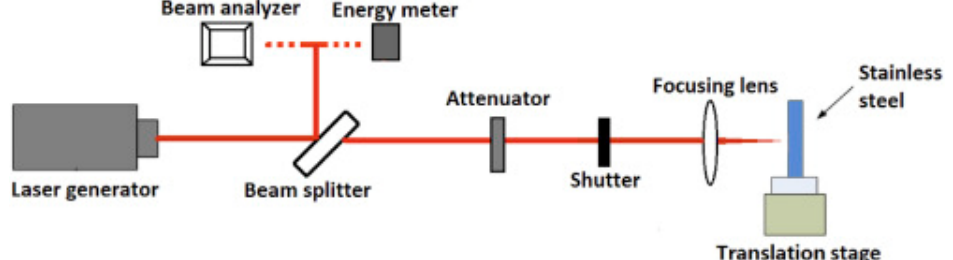
Figure 1. Schematic of laser treatment experimental setup. “Reprinted with permission from Ref. [32], Copyright (2017), Elsevier”.